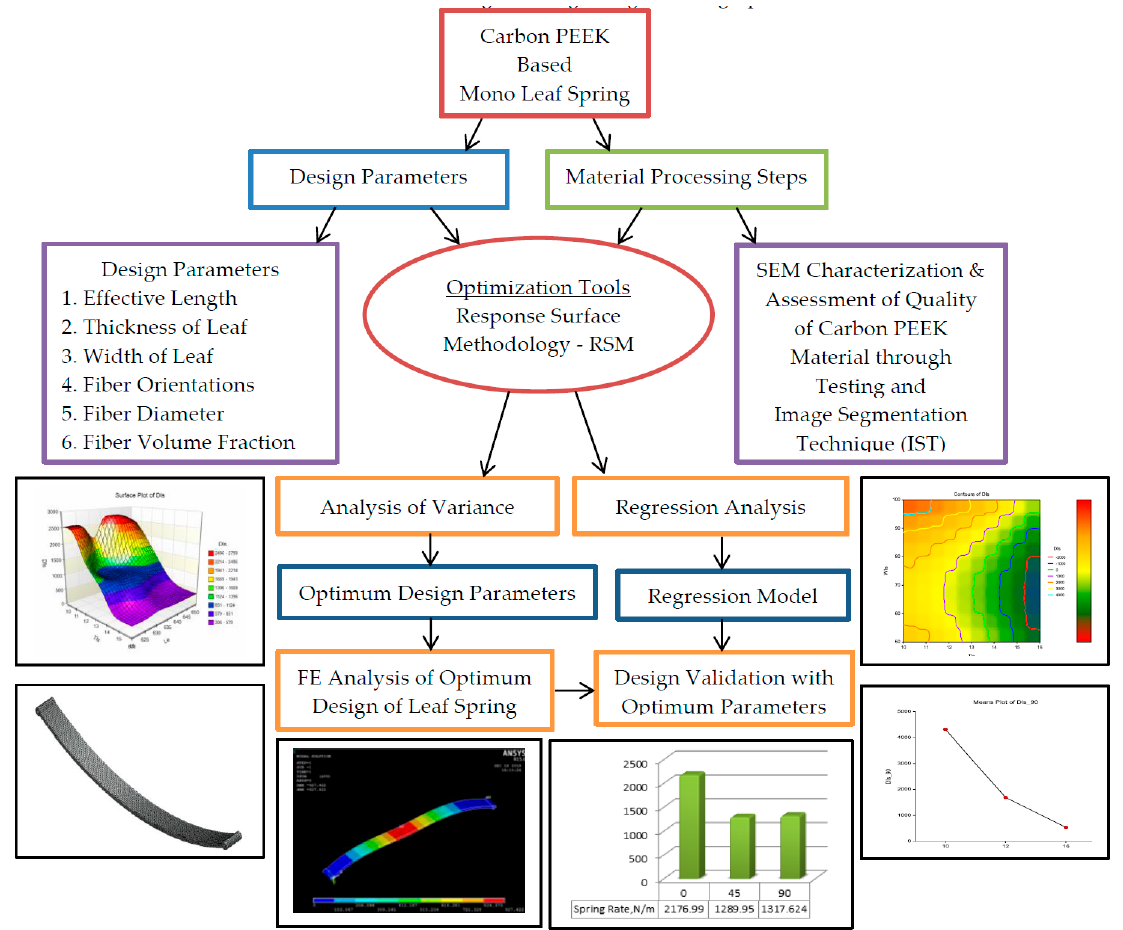
Figure 1. The procedural steps for design optimization.